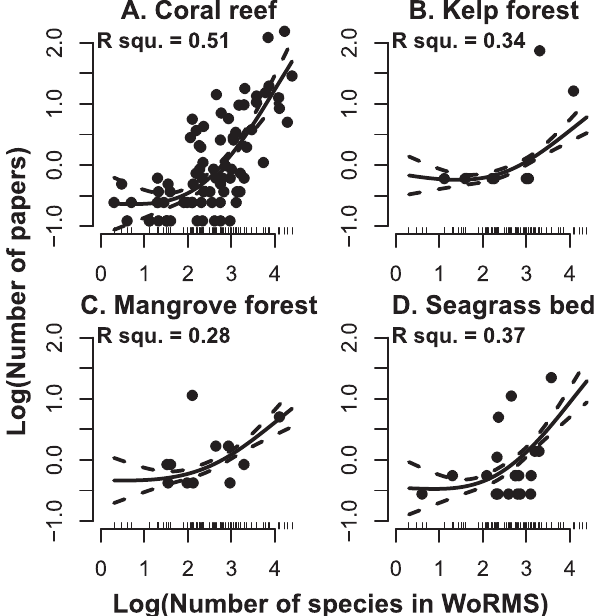
Figure 3. The relationship between the number of Web of Science H papers and currently named marine species richness. Log 10 number of papers as a function of the log 10 total number of valid species names contained in the World Registry of Marine Species. Solid lines are fitted Generalized Additive Models and dashed lines 95% confidence limits. Ecosystems are plotted individually in panels A–D.